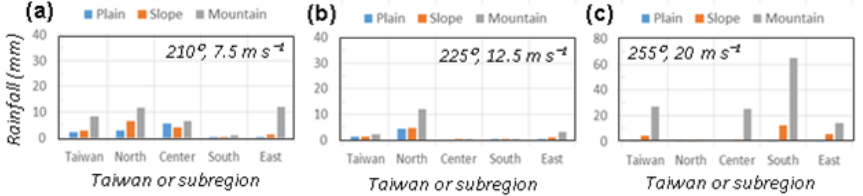
Figure 9. Spatial-averaged mean daily rainfall (mm) at the three elevation ranges (plain, slope, and mountain) over Taiwan and its four subregions in three experiments, with uniform southwesterly flow (a) from 210 ◦ at 7.5ms − 1 , (b) from 225 ◦ at 12.5ms − 1 , and (c) from 255 ◦ at 20ms − 1 . Note the difference in the scale of vertical axes.